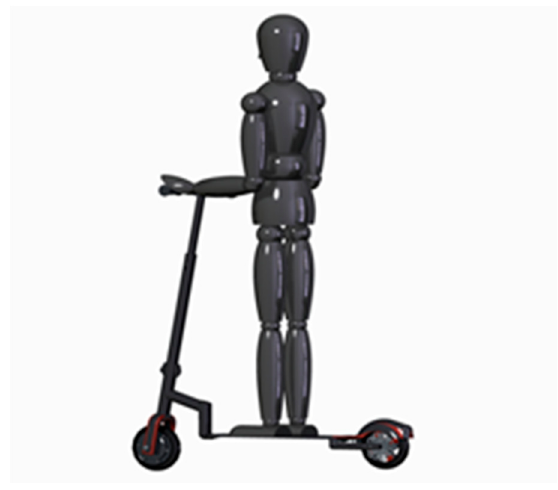
Figure 6. Kick Scooter Result.